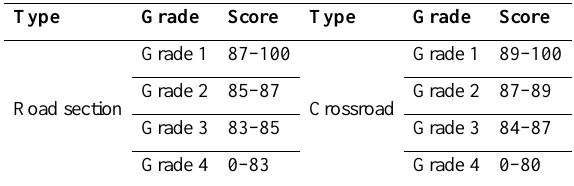
Table 6 Interval partition of